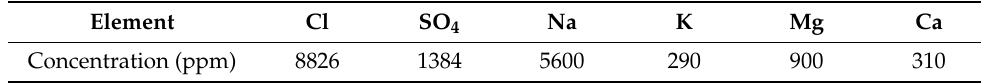
Figure 17. Comparison between pore water pH after reaction between CEM I and the Atlantic Ocean and North Sea water. Table 10. North Sea seawater analysis (taken from